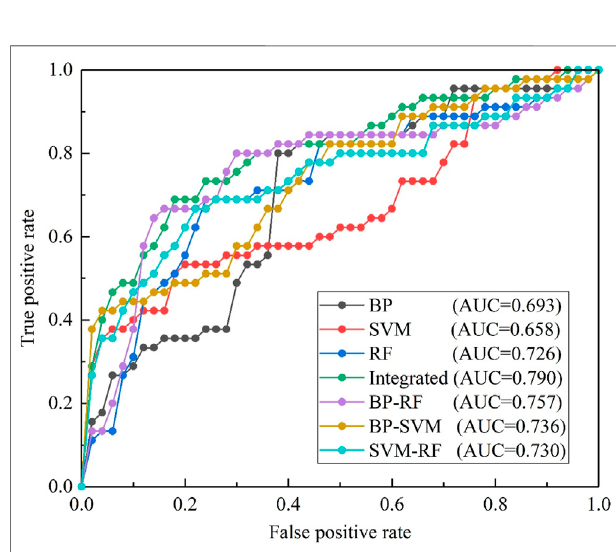
FIGURE 5 | ROC curves of various models ’ prediction